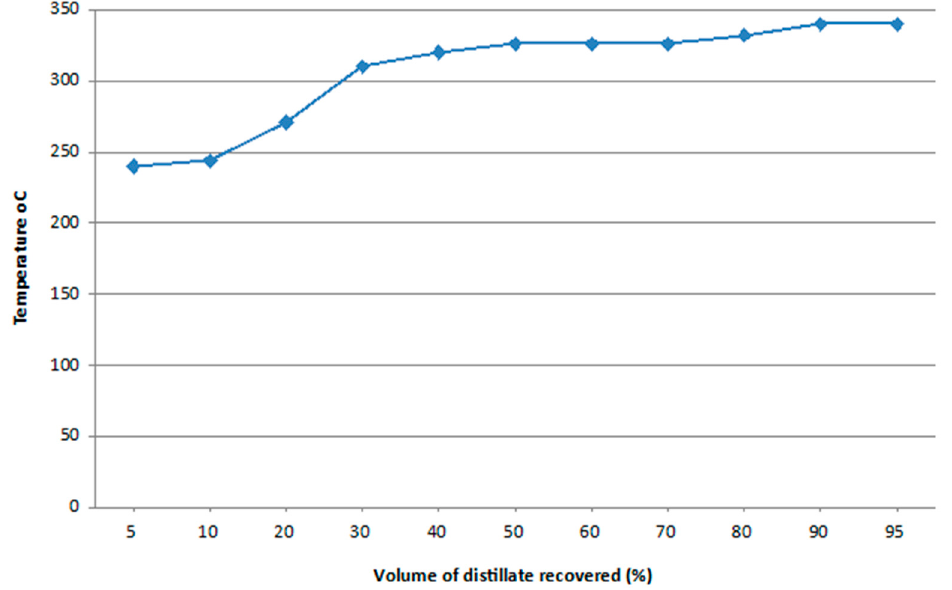
Figure 4. Relationship between volume of distillate recovered and temperature °C.